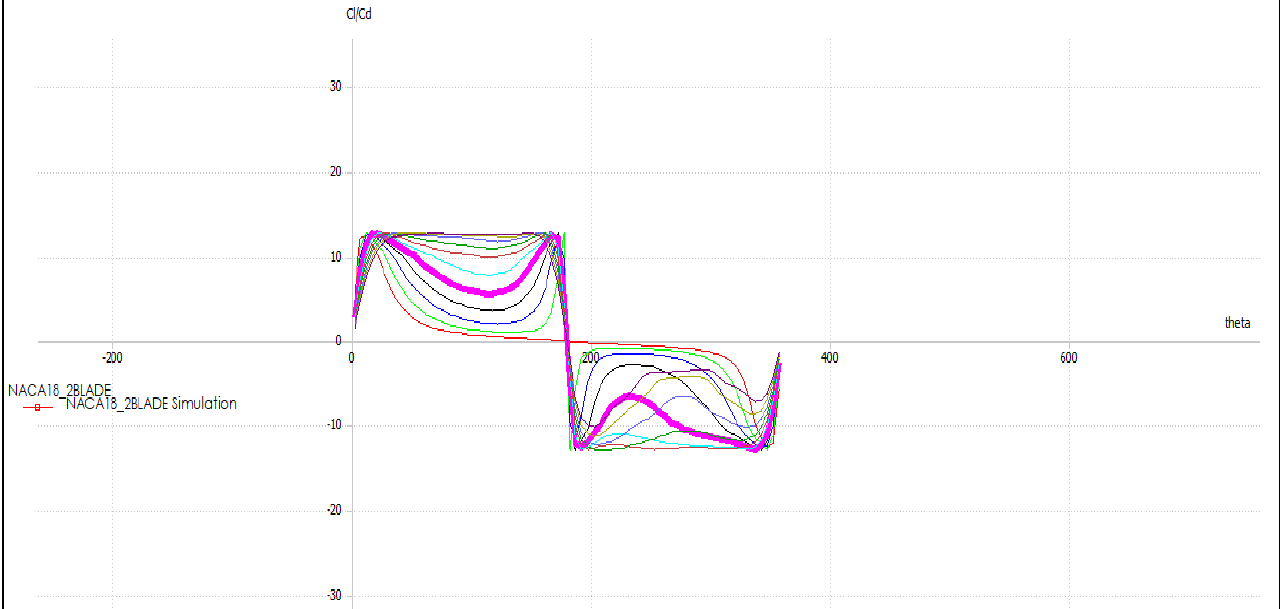
Figure 9. Cl/Cd vs theta plot of mid-section for TSR